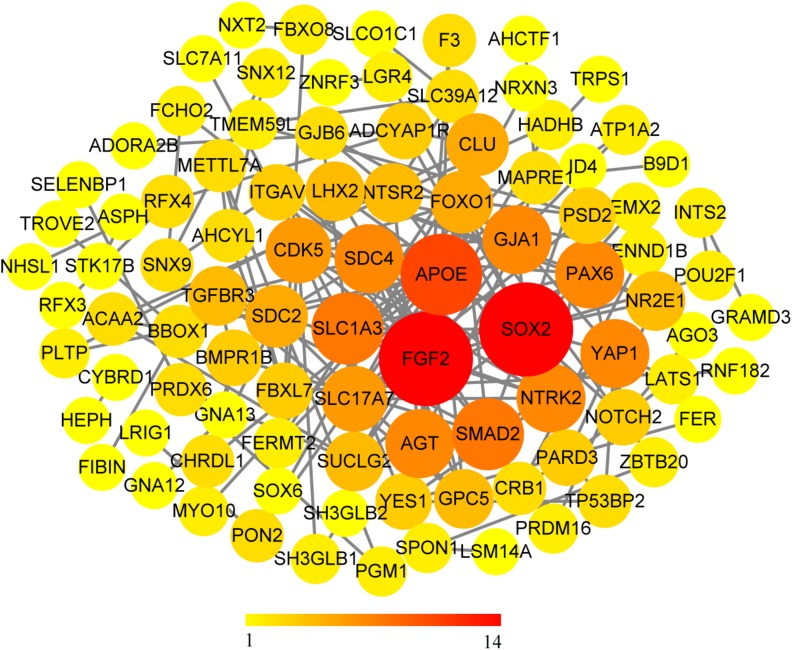
PPI network for all candidate modules.